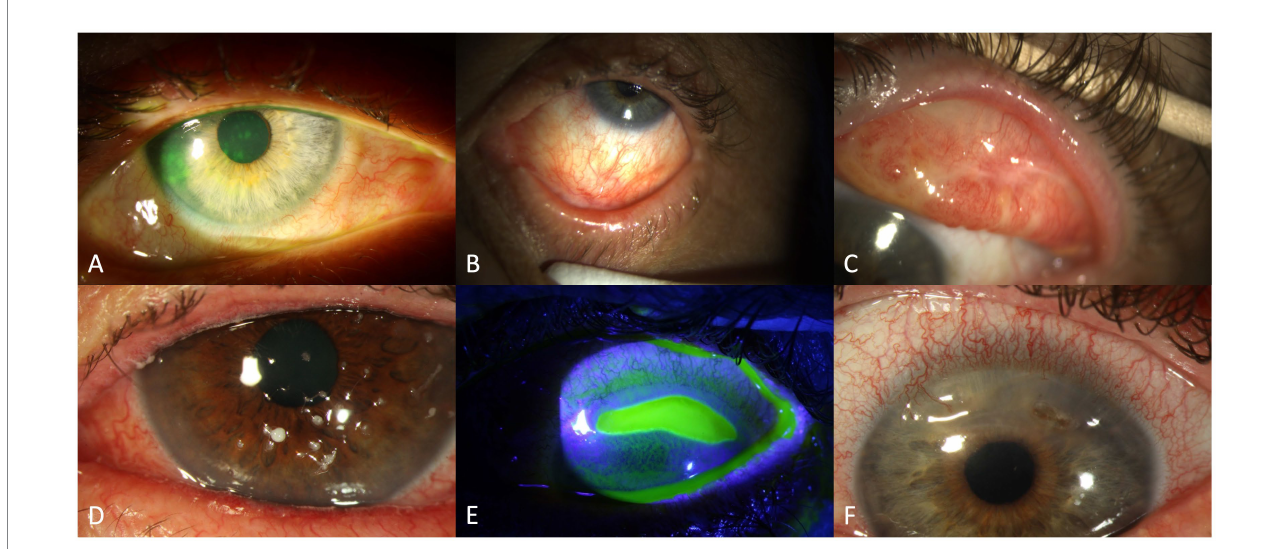
FIGURE 2 Findings in oGVHD: conjunctival hyperaemia and corneal staining (A) , conjunctival scarring/fibrosis (B) , conjunctival hyperaemia and symblepharon (C) , filamentary keratitis (D) , sterile corneal ulceration (E) and corneal melting with perforation (F)